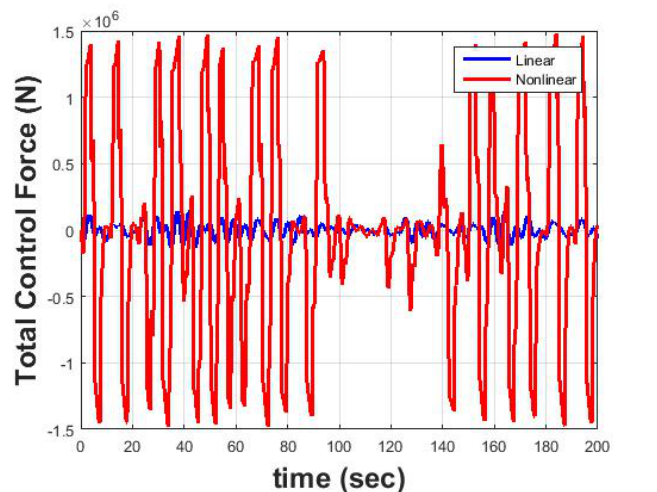
Figure 20. Comparison between the linear and nonlinear WECs in irregular waves: control